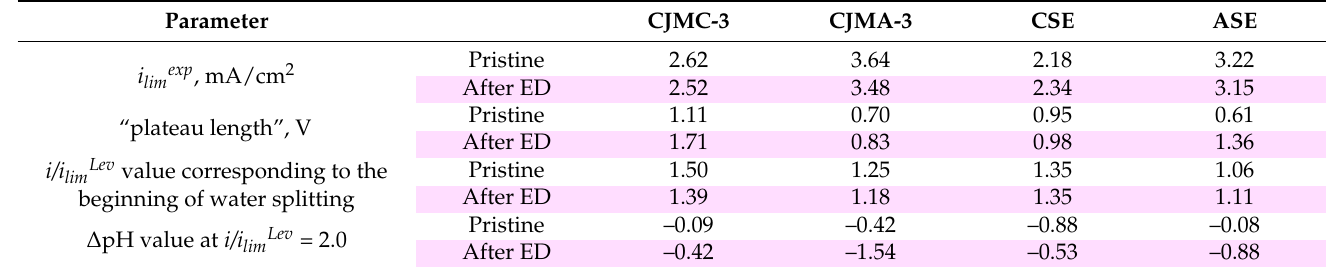
Table 5. Parameters of the current–voltage curves of the studied membranes before and after electrodialysis processing of the model